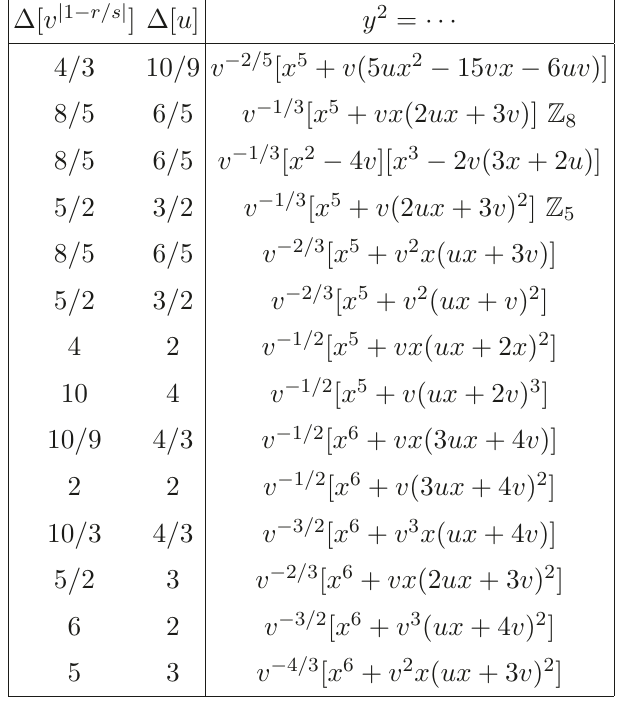
Table 7 . The geometries in refs. [19, 20] with multivalued symplectic structure. First two columns contain the cover Coulomb dimensions; third one the hyperelliptic